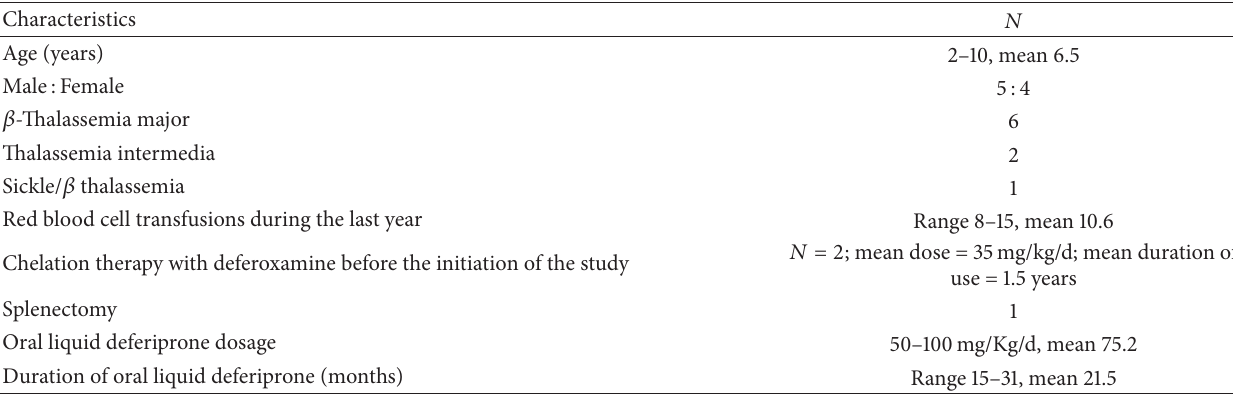
of deferiprone (Ferriprox 100mg/mL).